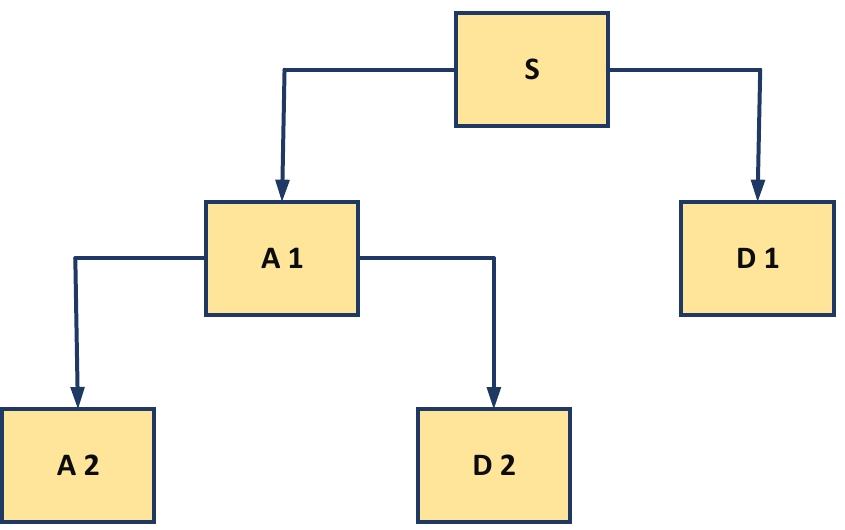
Figure 2. Decomposition tree of discrete wavelet transforms.